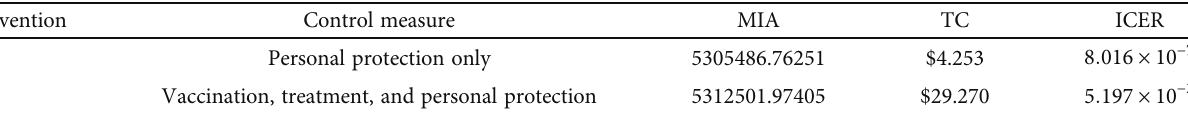
Table 11: Comparing ICER I 3 with I 7